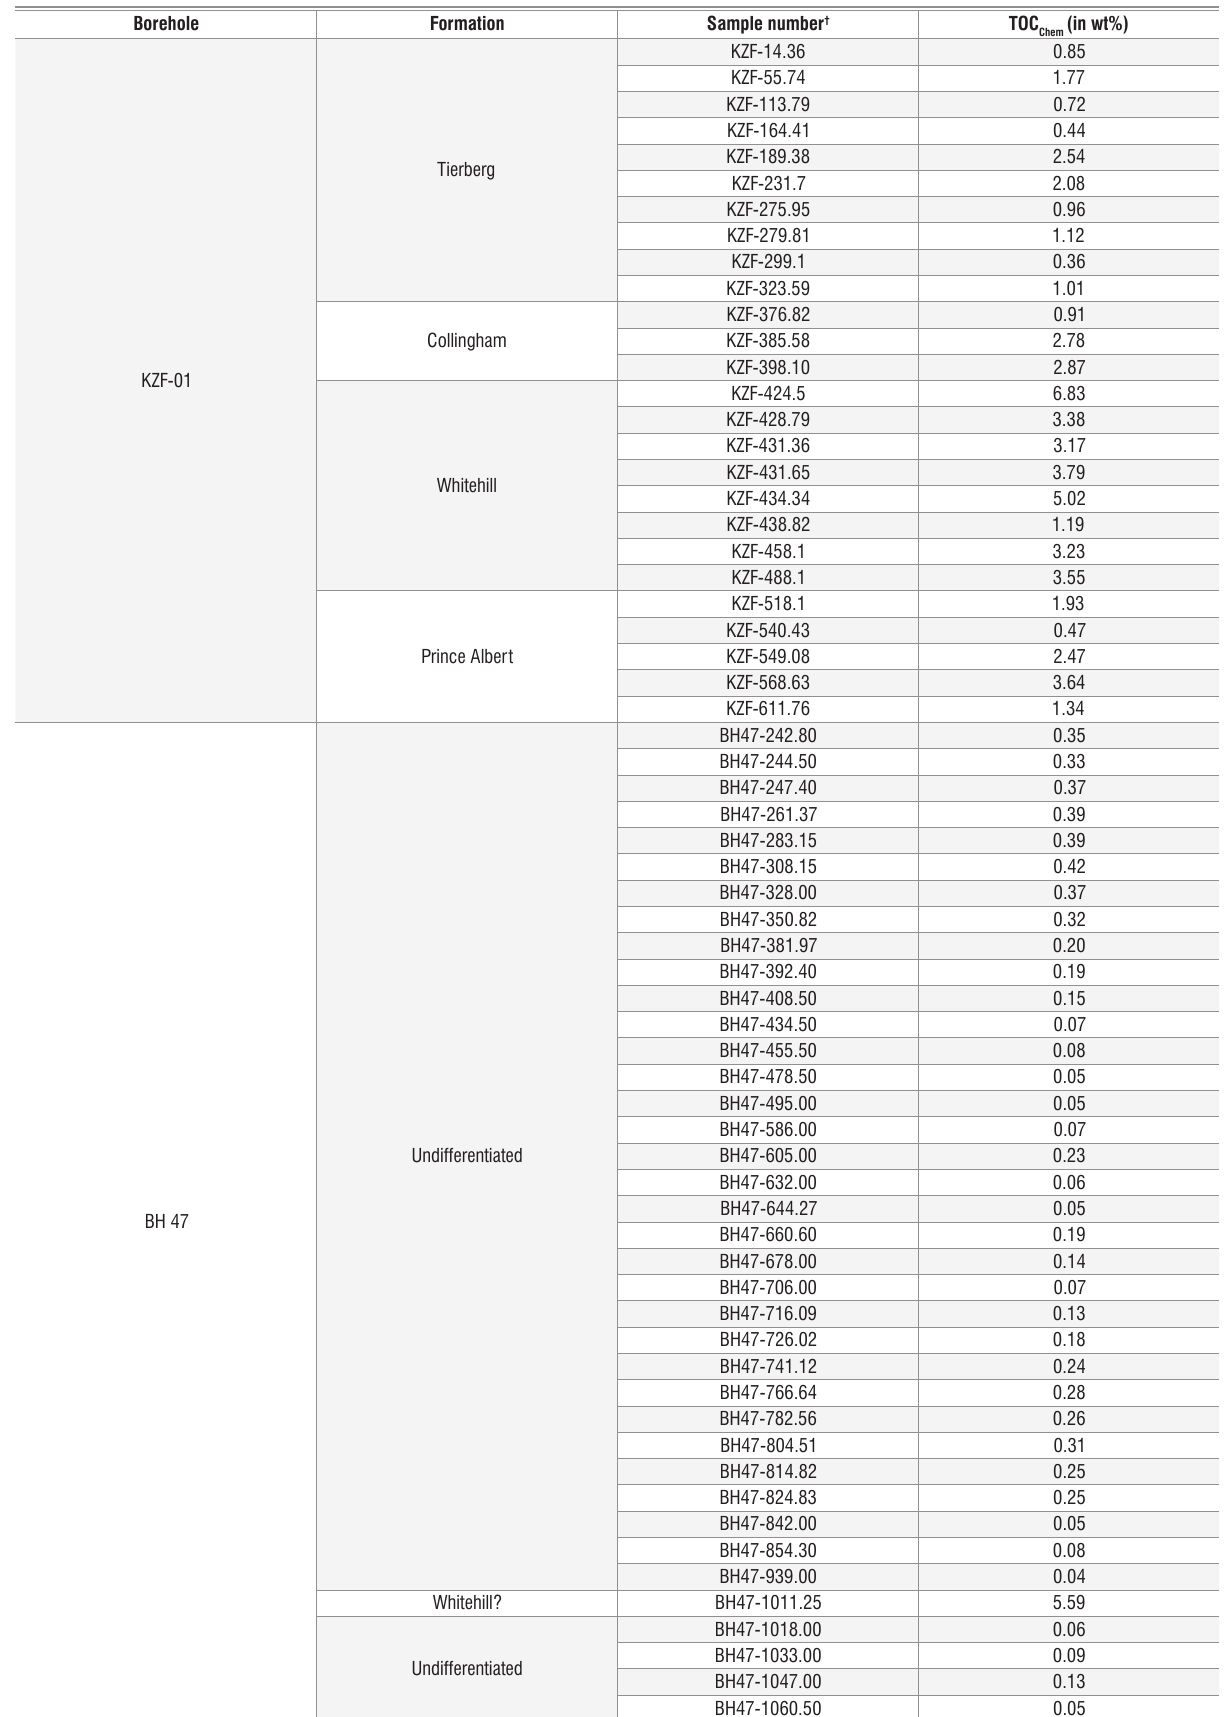
Table 3: Total organic carbon (TOC